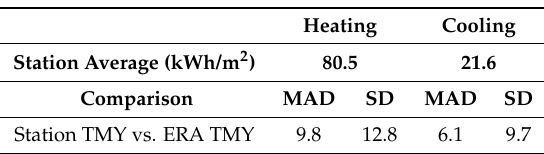
Table 4. Average energy consumption kWh/m 2 and statistical deviation between different data sources calculated according to Equations (5) and (6) for the office building.